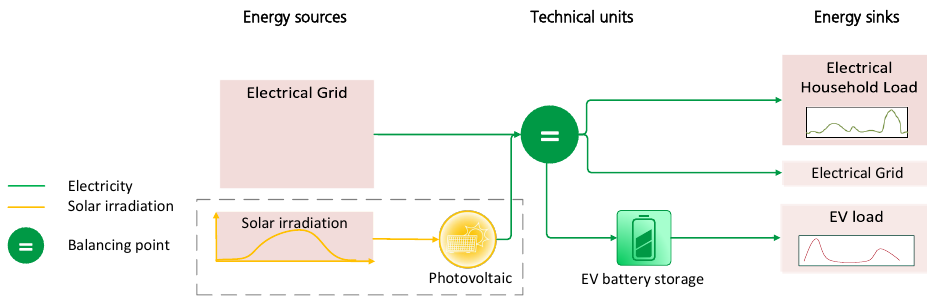
Figure 10. Visualization of the optimization model